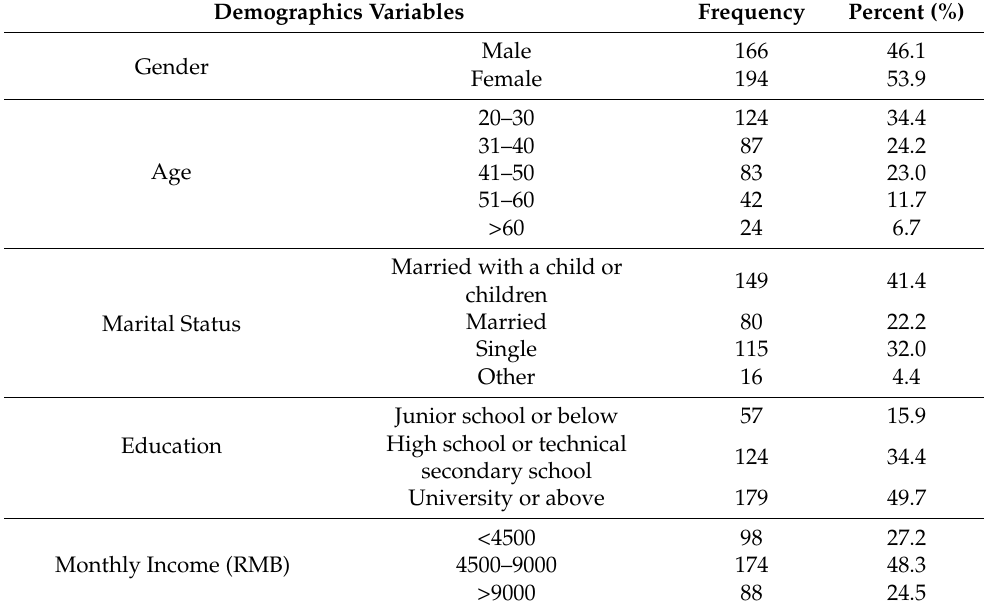
Table 1. Demographics of samples ( n =